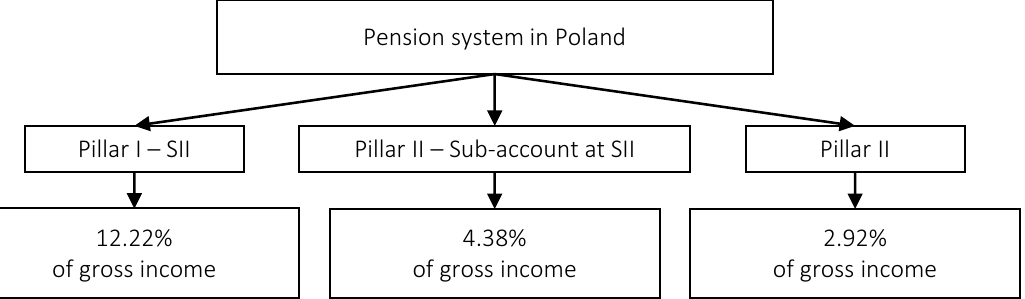
Figure 2. Construction of the pension system in Poland – as of February 1, 2014